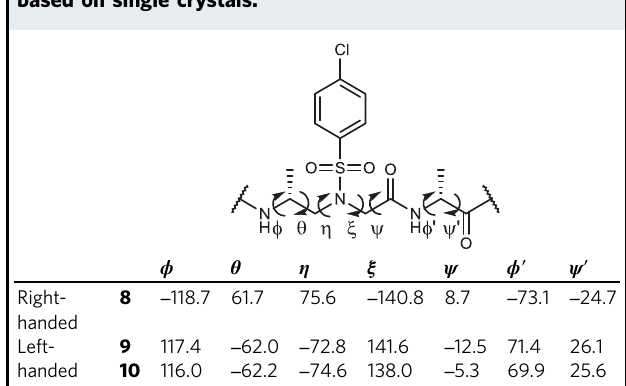
Fig. 5 Left-handed foldamer. a CD spectra of 1:1 D - α / D -sulfono- γ -AA hybrids 9 and 10 (100 μ M) measured at room temperature in CH 3 OH, foldamer 8 was included as a mirror comparison. b Single-crystal structures of left-handed helix formed by D -15-mer 9 . Single-crystal structures of right-handed helix formed by L -15-mer 8 was employed as a mirror comparison. c Single-crystal structures of left-handed helix formed by D -17-mer 10 . The nonpolar hydrogens were omitted for clarity. Solvent molecules were also excluded from the crystal lattice. Table 3 Typical torsion angles (°) in foldamers 9 and 10 based on single